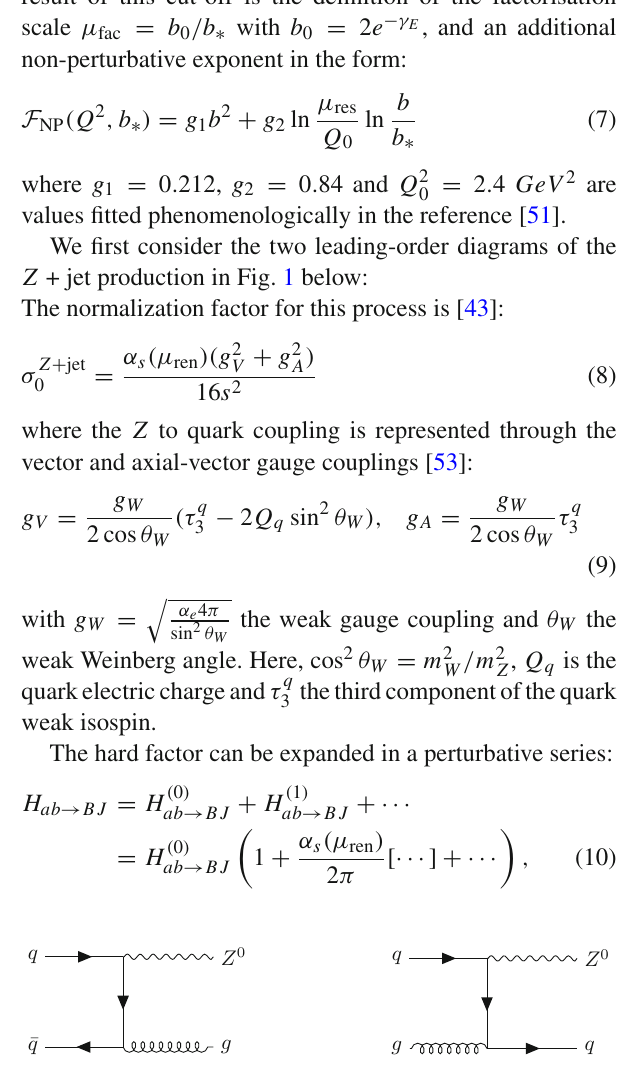
Fig. 1 Two examples of the lowest order partonic scattering diagram for Z + jet